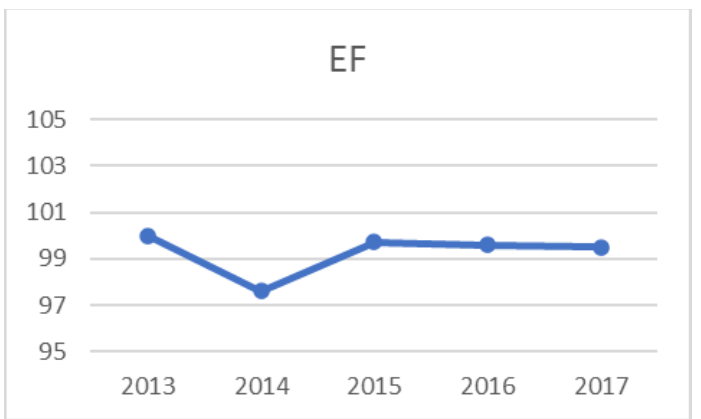
100%. Figure 16. Italian population growth trend from 2013 to 2017. The 2013 value (59701104) is set to